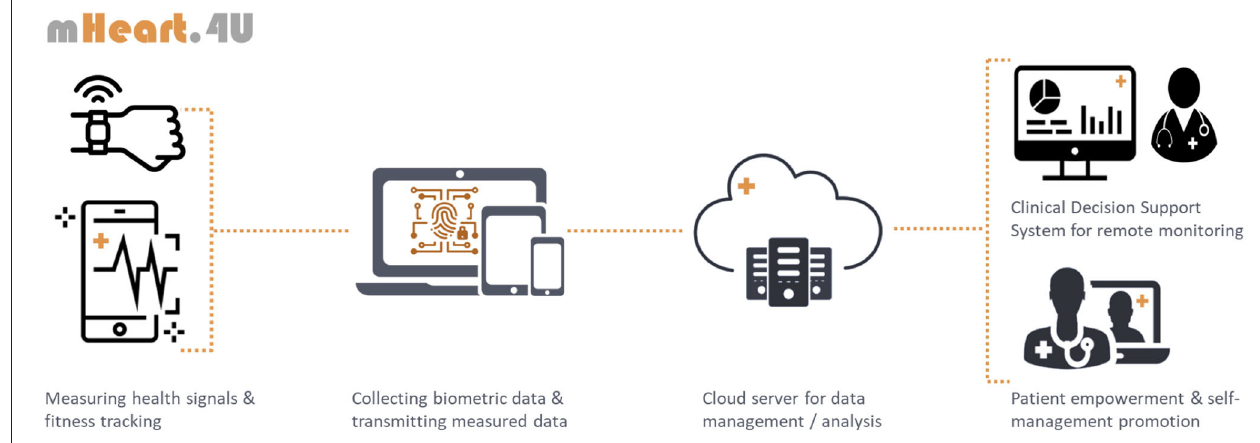
FIGURE 2 | Overview of the mHeart.4U framework and functioning.